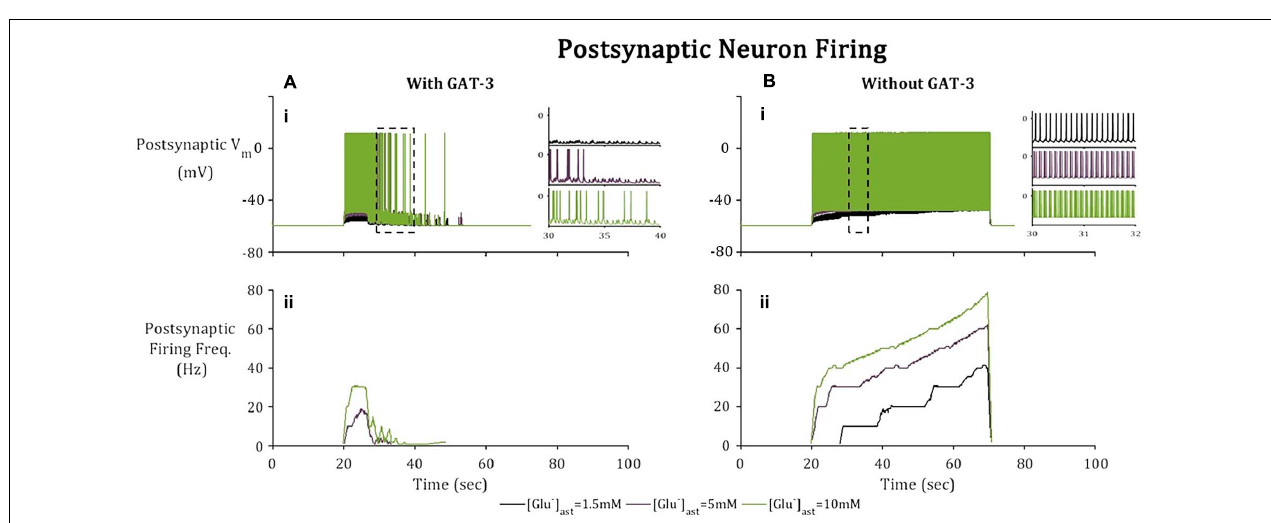
FIGURE 6 | Postsynaptic neuronal activity in model simulation across 3 paradigms, [Glu] ast = 1.5, 5, and 10 mM. Postsynaptic neuronal membrane is subject to (A) NMDA, AMPA, and GABA A mediated currents with inclusion of astrocytic GAT-3-mediated GABA transport and (B) where the GAT-3-mediated GABA release has been omitted. (i) Postsynaptic neuron membrane potential and (ii) firing frequency as a result of an applied current (pulsed at a frequency of 10 Hz over a 50 s window starting at 20 s). All graphs depict firing frequency calculated using a moving average using window size 1 s, 10% overlap). Inset Figs describe 10 s window (left) for each of the basal [Glu] ast and 2 s window (right) for each basal [Glu] ast , where the time window was selected according to extent of neuronal activity.